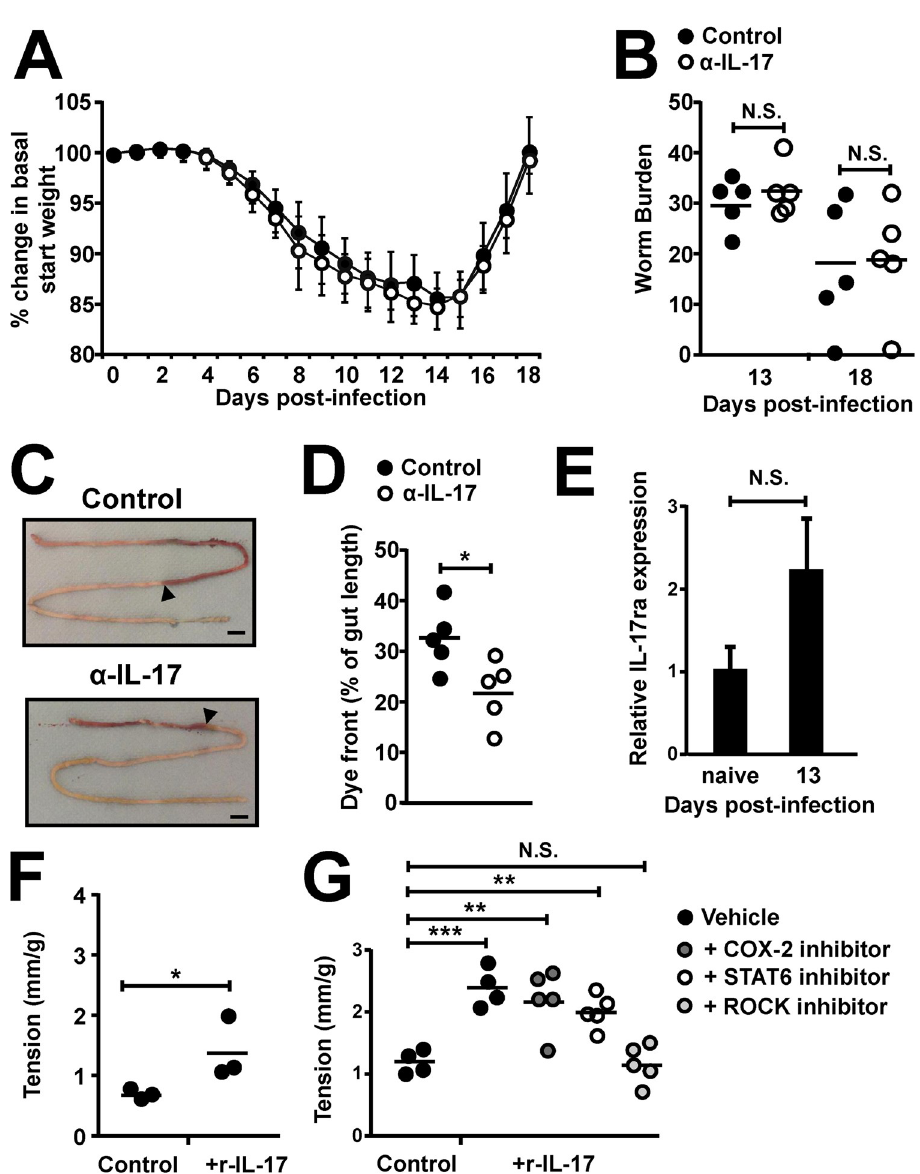
Fig 4. IL-17 drives intestinal muscle hypercontractility during T . spiralis infection and ex vivo via the ROCK signalling pathway. C57BL/6 mice were infected with 300 T . spiralis larvae and treated with 100 μ g of anti-IL-17 or control antibody (Bio-X-Cell) every 3 days from day 7 post-infection. (A) Percentage change in basal start weight in control and α -IL-17 treated mice over the course of infection. (B) Worm burdens from control and α -IL-17 treated mice at days 13 and 18 p.i. Chow was removed 12 hrs prior to sacrifice at day 13 and mice received 200 μ ls carmine red in methylcellulose 20 minutes before sacrifice. (C) Representative macroscopic images, arrow indicates front of dye and scale bar = 1 cm, and combined data (D) . Data (n = 5 mice per group) are from two independent experiments performed. (E) Expression of IL-17ra in isolated jejunal muscle layer at rest and day 13 p.i, via qPCR relative to HPRT housekeeping gene. (F) Isolated jejunal strips from C57BL/6 wild-type mice were incubated in media with/without the addition of 10ng/ml rIL-17 for 6 hours prior to measuring longitudinal muscle tension generated in response to carbachol (10 -6 M) in an isolated tissue bath and (G) with/without the prior addition of the COX-2 and ROCK inhibitors celecoxib (10 μ M) and Y-27632 (10 μ M) and STAT6 inhibitor AS1517499 (100nm). Data (n = 3–5 mice per group) are from two independent experiments performed. � , P < 0.05; �� , P < 0.01; ��� , P < 0.005; N.S., not significant via Bonferonni’s multiple comparison following ANOVA (G) and student’s t-test (A) , (B) , (D) , (E) and (F) for indicated comparisons between